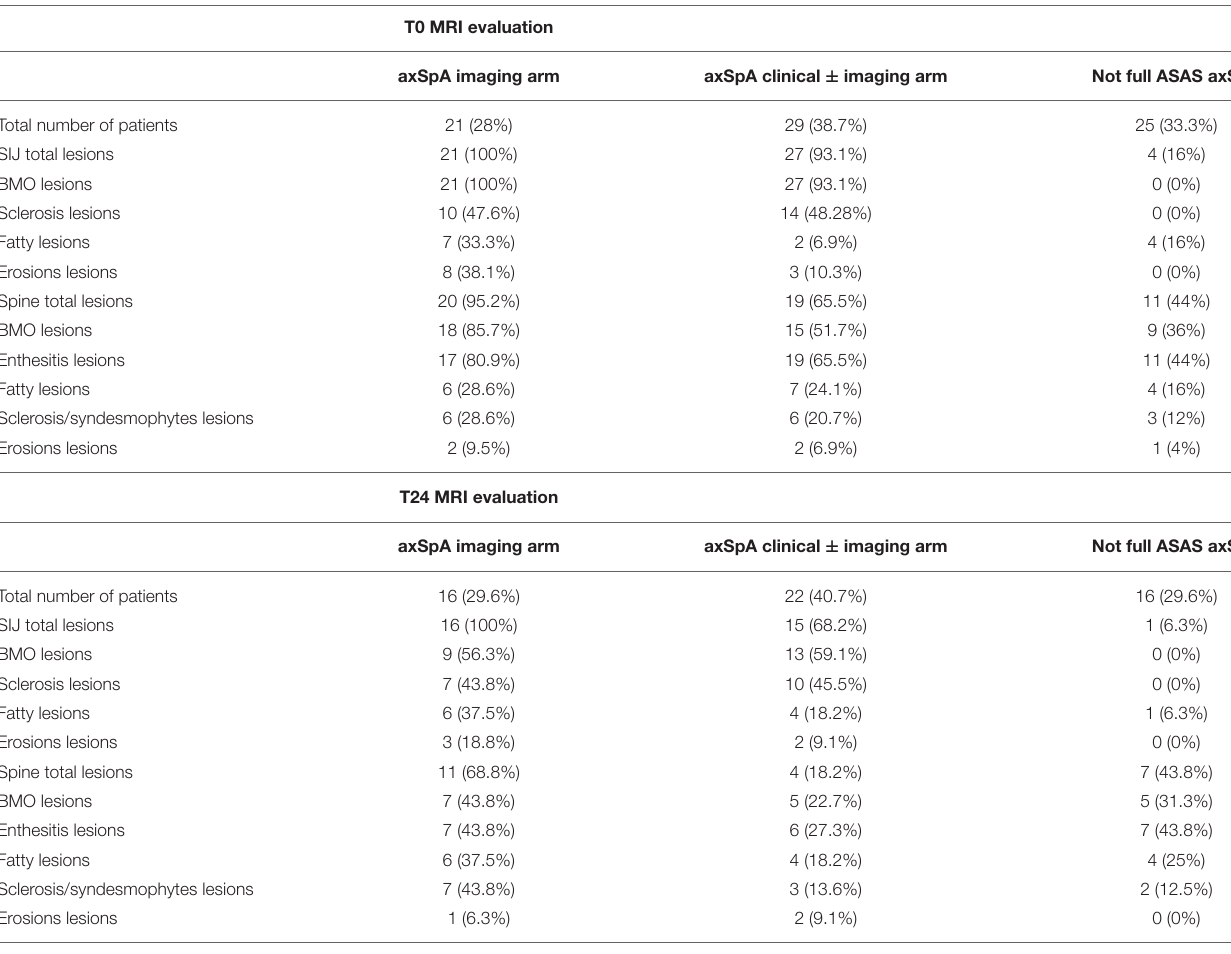
TABLE 2 | The prevalence of inflammatory and structural lesions at T0 and T24 in three cohorts ( axSpA imaging arm, axSpA clinical ± imaging arm, not full ASAS axSpA ). T0 MRI